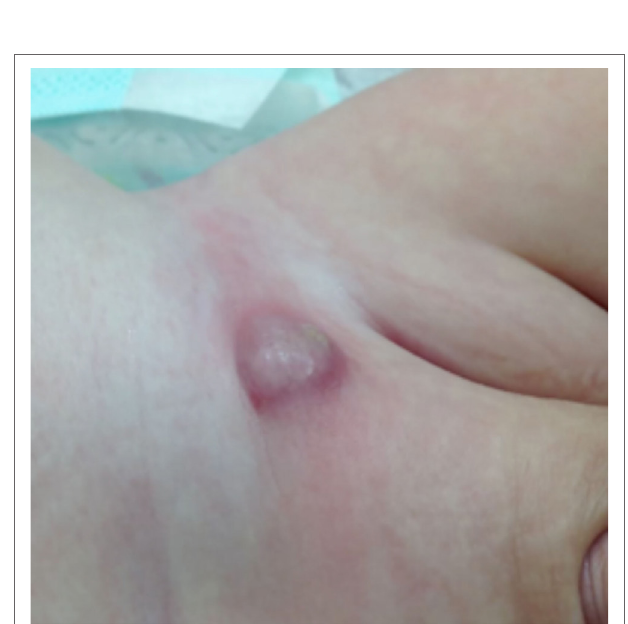
FigUre 2 | Inguinal foreign-body reaction, a postoperative complication emerging 4 weeks after surgery.